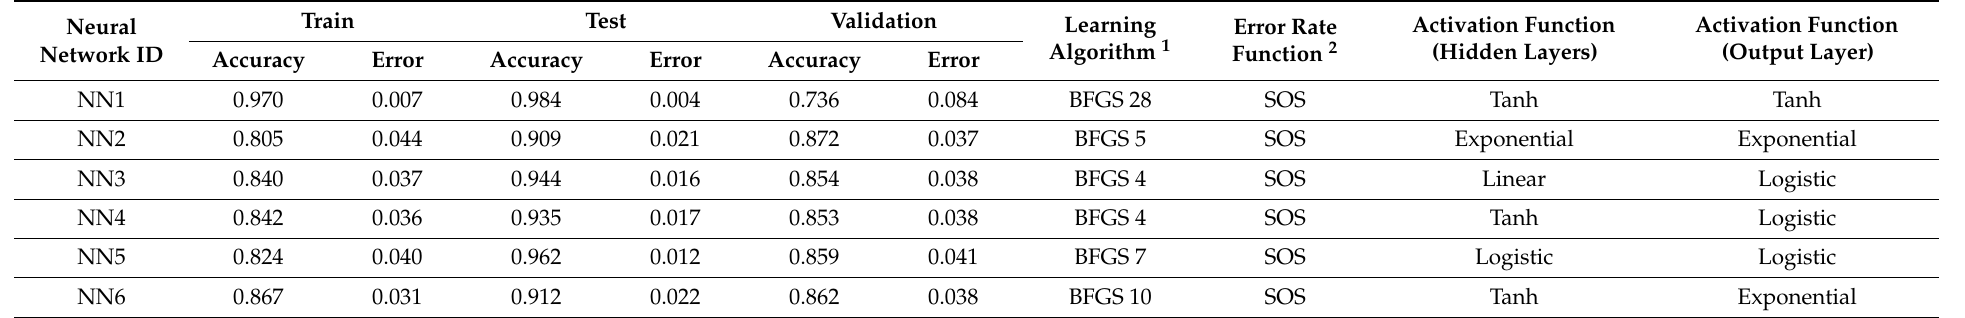
Table 9. The overall performance for 6 neural network models for caries